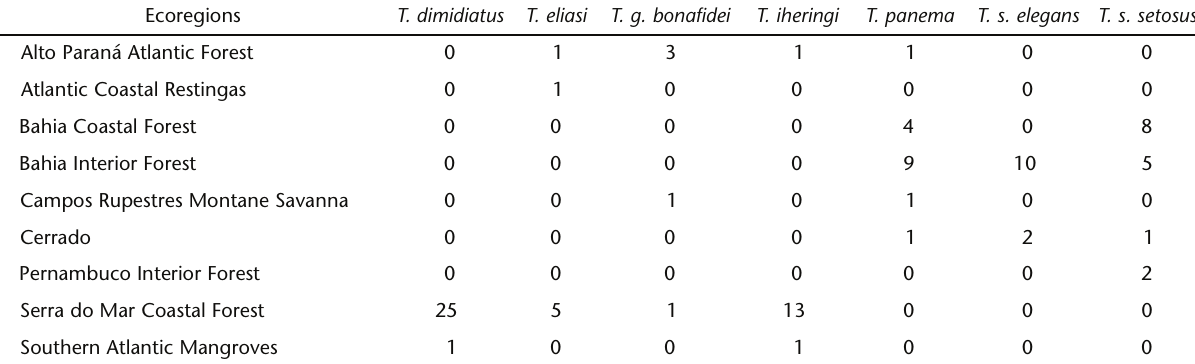
Table III. The occurrence of six Trinomys species by ecoregions. Ecoregions are according to O LSON et al. 2001. Ecoregions